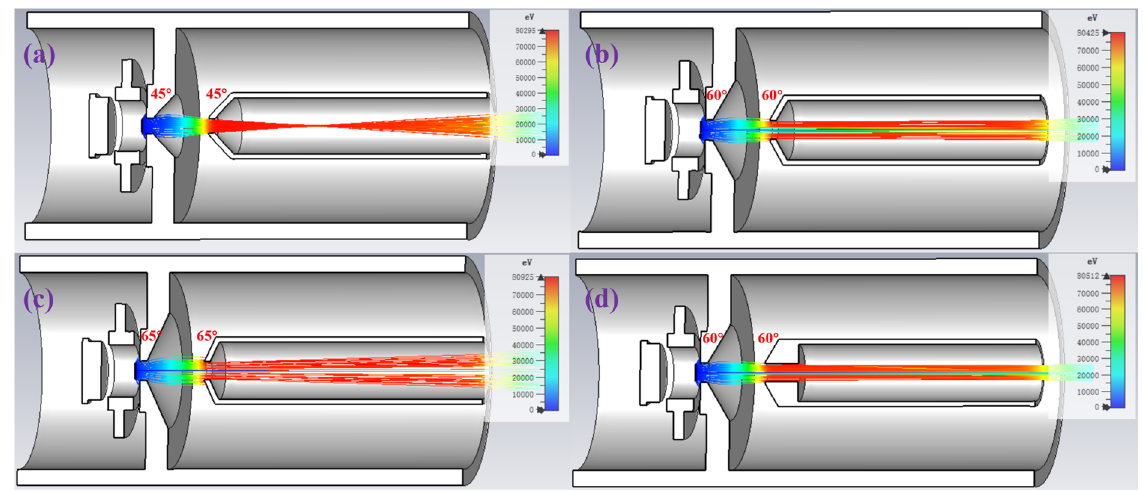
FIG. 5. Simulation results of deuterium ion extraction under different extraction electrode structures. The extraction voltage is fixed at − 80 kV. (a) electrode angle of 45°, (b) electrode angle of 60°, (c) electrode angle of 65°, (d) electrode angle of 60° with